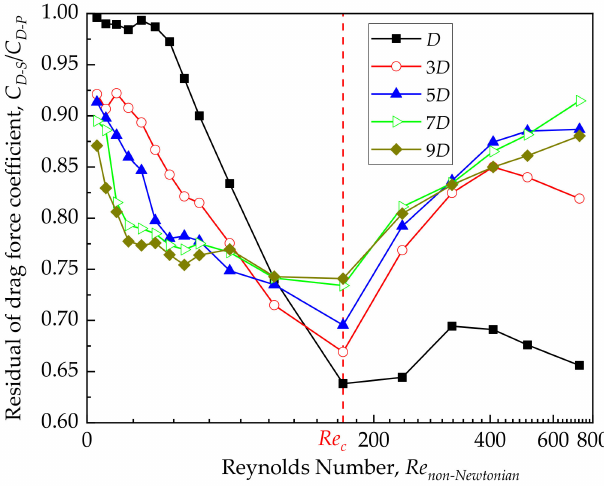
Figure 12. Relationship between residual of drag force coefficient ( R ) and Re non-Newtonian